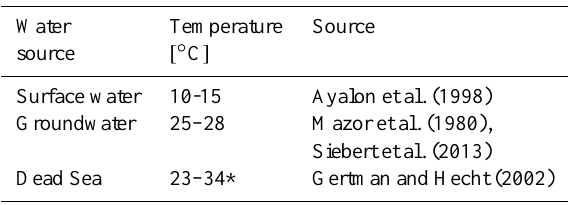
Table 1. Temperatures of important waters influencing the thermal pattern of the